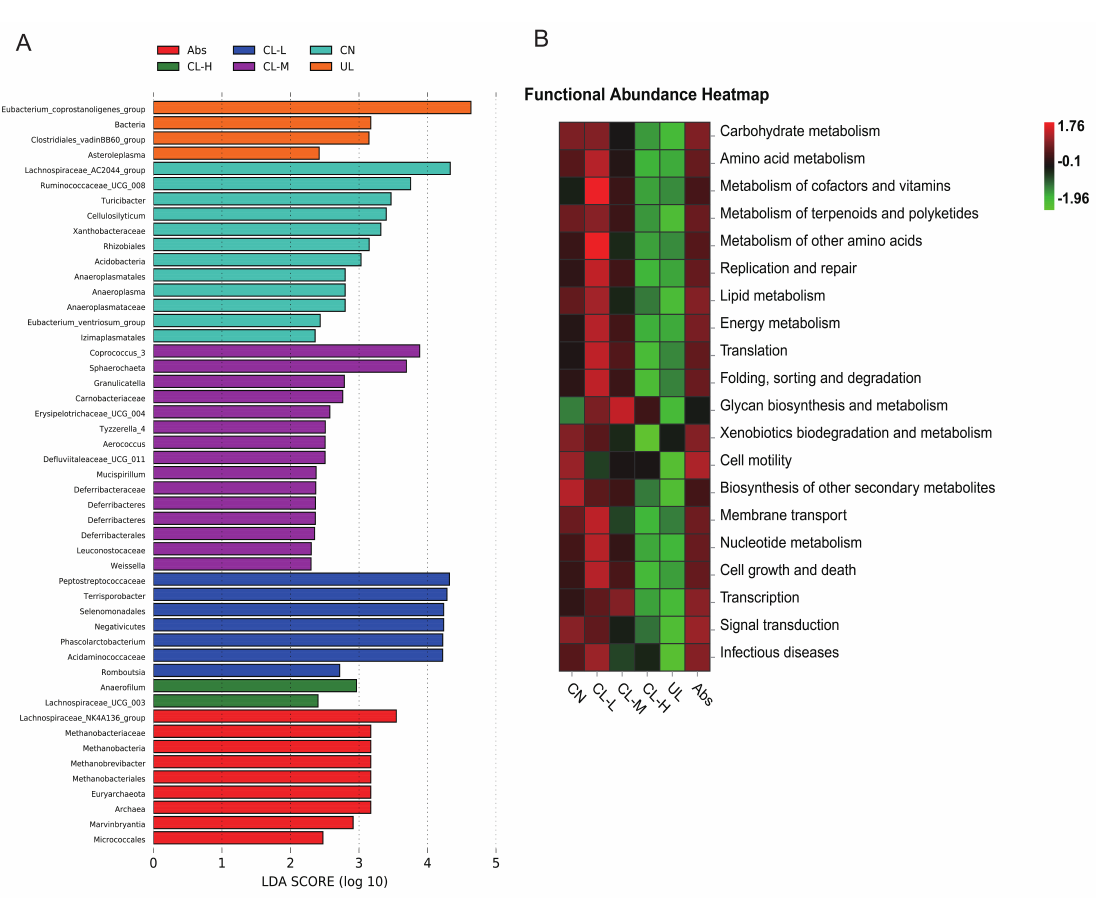
Figure 6. Summary of the microbial community in the cecal contents of piglets. ( A ) LEfSe. ( B ) Second- level KEGG pathway analysis of the predicted functions of the colonic